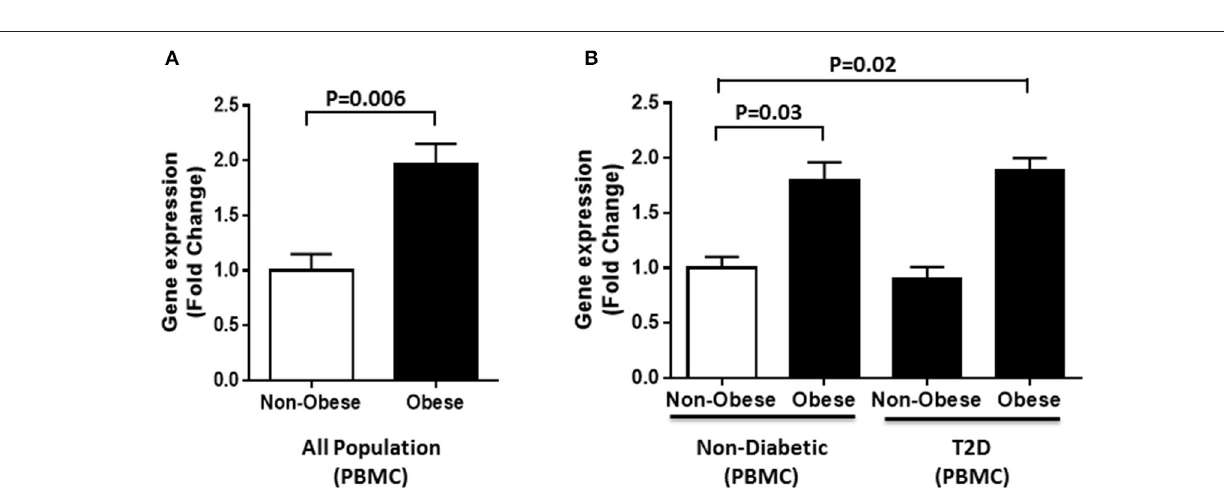
positive correlation with fold change) in PBMC ( r = − 0.381; P = 0.003) and adipose tissue ( r = − 0.574; P < 0.001). However, DNAJC27 in PBMC and adipose tissue ( r = 0.777; P < 0.001) ( Supplementary Figure 2